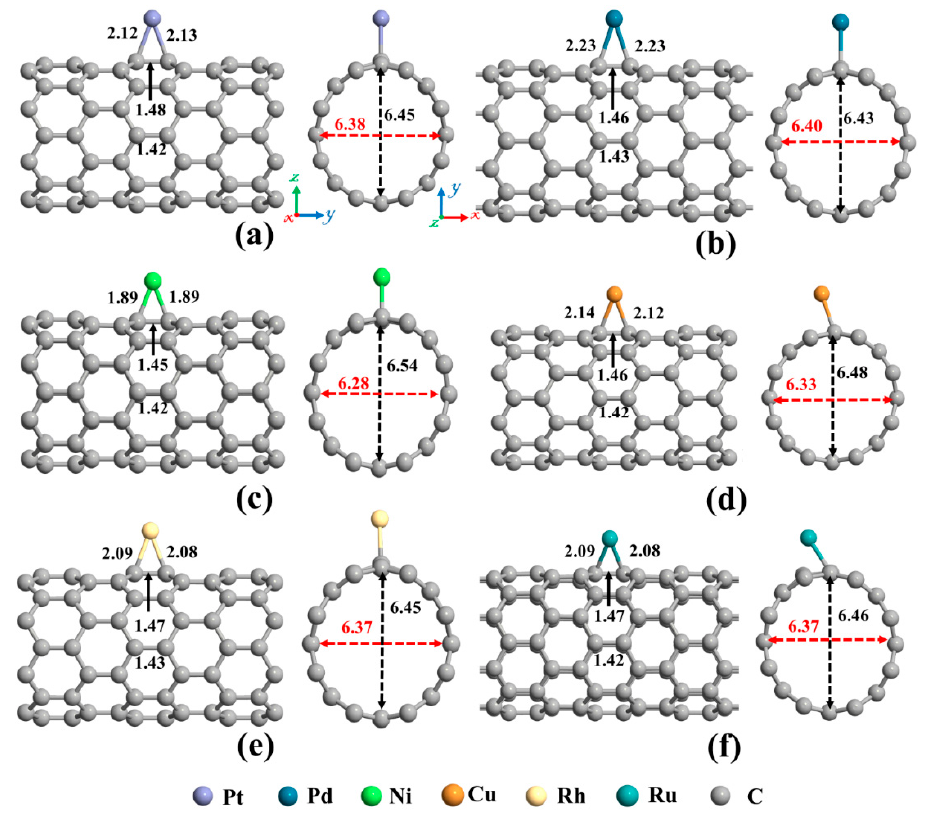
Figure 4. The optimized structures of a single ( a ) Pt, ( b ) Pd, ( c ) Ni, ( d ) Cu, ( e ) Rh, and ( f ) Ru decorated (8,0) SWCNT. The bond lengths, the diameters, and the binding distances between the metal atom and the nanotube are also given in the unit of Å. The sticks between atoms are only for visualization. The red and black dotted arrows present the diameter of the nanotube parallel and perpendicular orientation to the axis of the nanotube, respectively